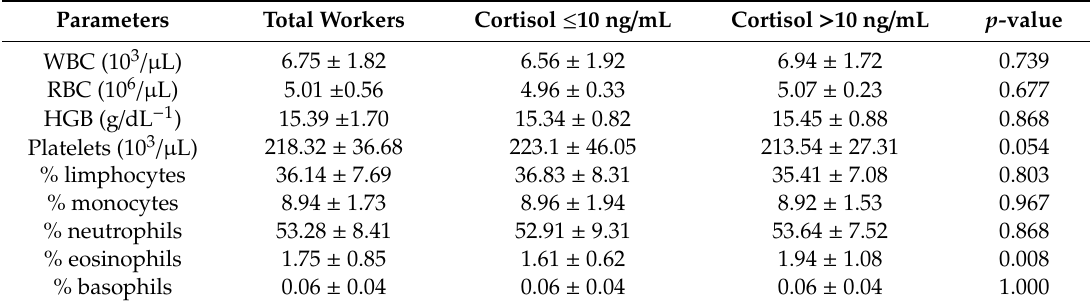
Table 2. Number of blood cells in overall workers and workers with cortisol levels ≤ or > 10 ng / mL.